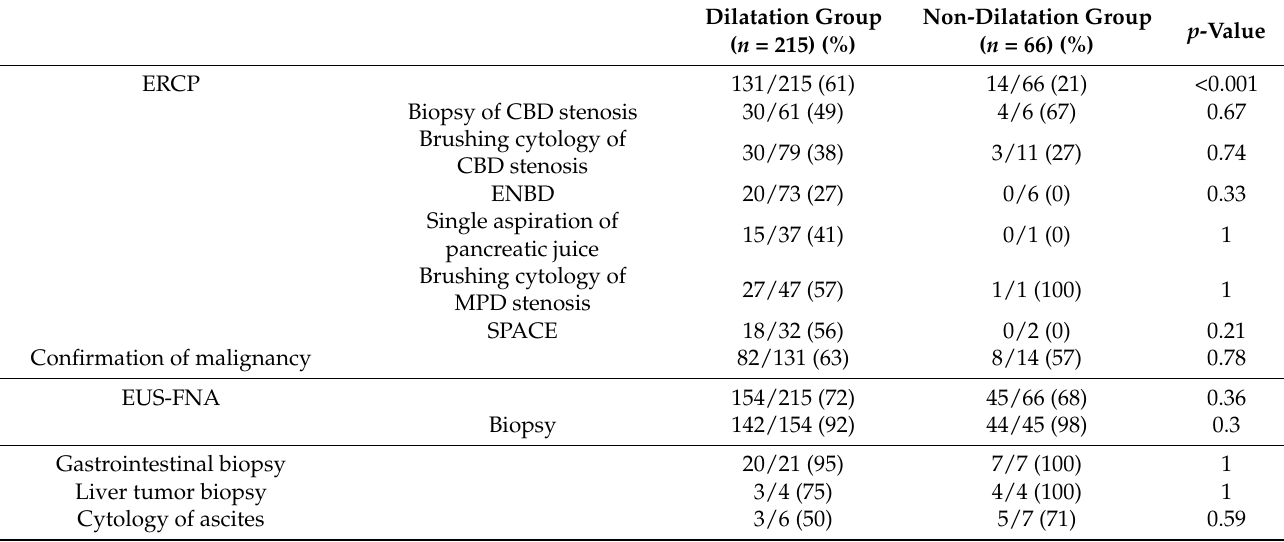
Table 4. Histopathological